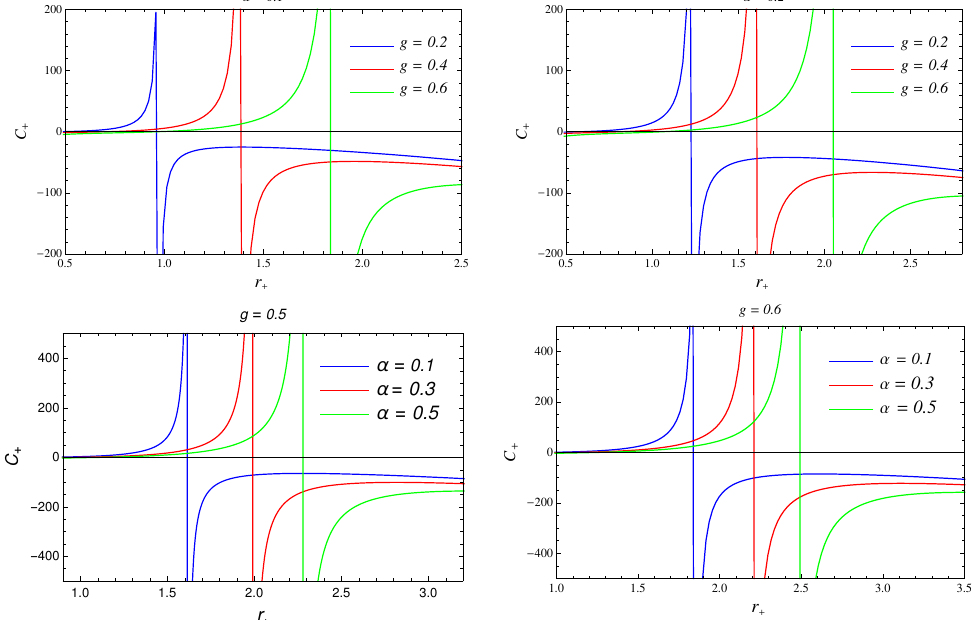
Figure 4. Specific heat C + vs horizon r + for different values of g and α